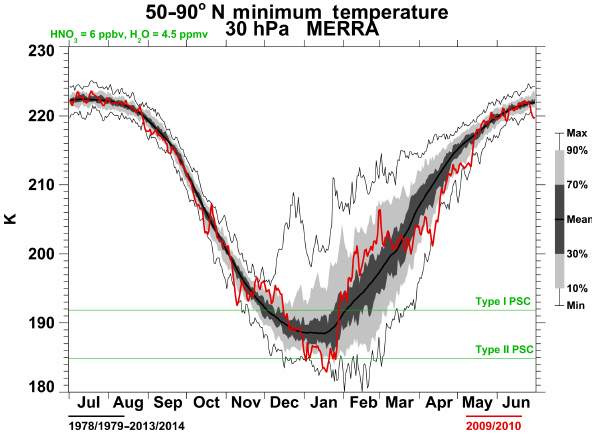
Figure 1. Variation of the minimum temperature (50–90 ◦ N) in the Arctic stratosphere at 30hPa by Modern-Era Retrospective analy- sis for Research and Applications (MERRA) data. The thick black line shows the average minimum temperature between 1978/79 and 2013/14, while the thick and thin shaded area represents 30–70 and 10–90% percentile distributions, respectively. The red line shows the minimum temperature in the 2009/2010 Arctic winter. Two hor- izontal green lines represent the Type I (NAT) PSC threshold tem- perature assuming 6ppbv HNO 3 and 4.5ppmv H 2 O, and the Type II (ice) PSC frost point temperature,